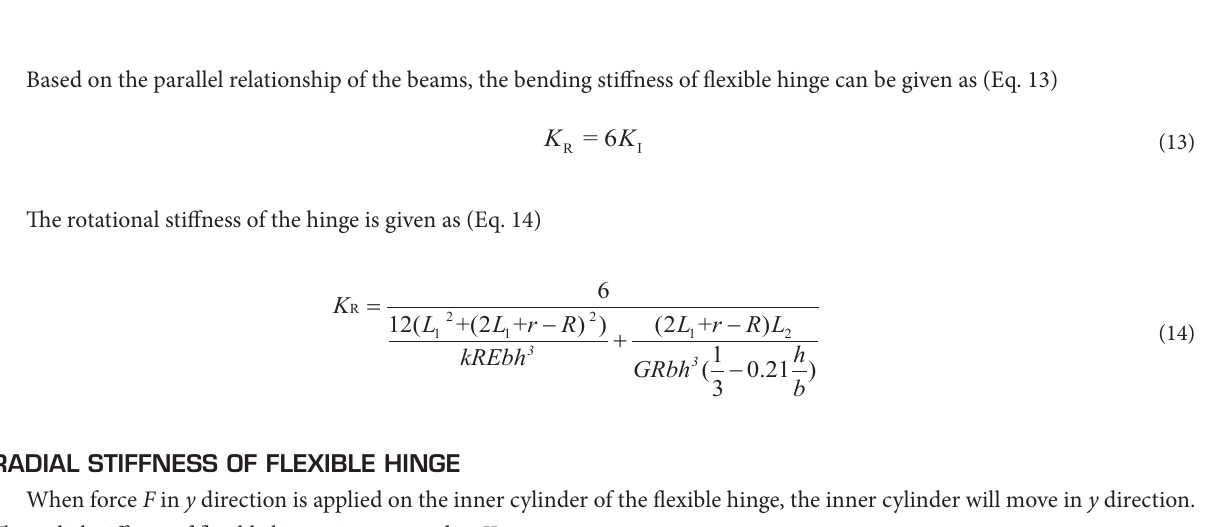
Figure 6. The corresponding arc and angle diagram of the torsion beam. Because L 1 is close to the distance of the outer ring from the inner cylinder, the angles θ 2 and α 2 are close to each other when the rotation of the hinge is caused by the torsion of the beams 2 and 4. Since the arc lengths of θ 2 and α 2 are approximately equal, the angles satisfy (Eq. 10) (10) Based on Eqs. 9 and 10, the torsional stiffness of beams 2 and 4 can be given as (Eq. 11) (11) Considering the series relationship of the deformed beams, the rotational stiffness of one unit of the hinge can be given as (Eq. 12)